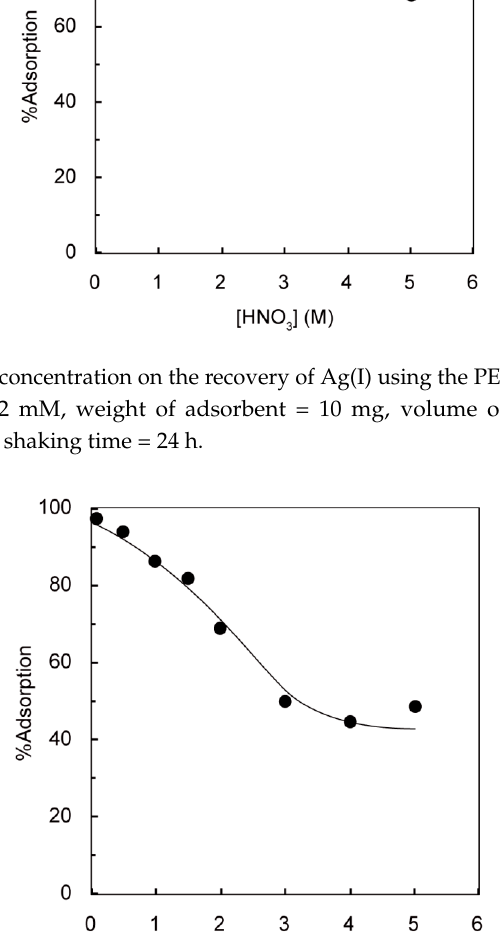
Figure 3. Effect of thiourea concentration on the adsorption of Ag(I) on the PEI ‐ MAR. Conditions: Ag(I) concentration = 0.2 mM, weight of adsorbent = 10 mg, H 2 SO 4 concentration = 0.05 M, volume of test solution = 10 mL, temperature = 30 °C, and shaking time = 24 h.